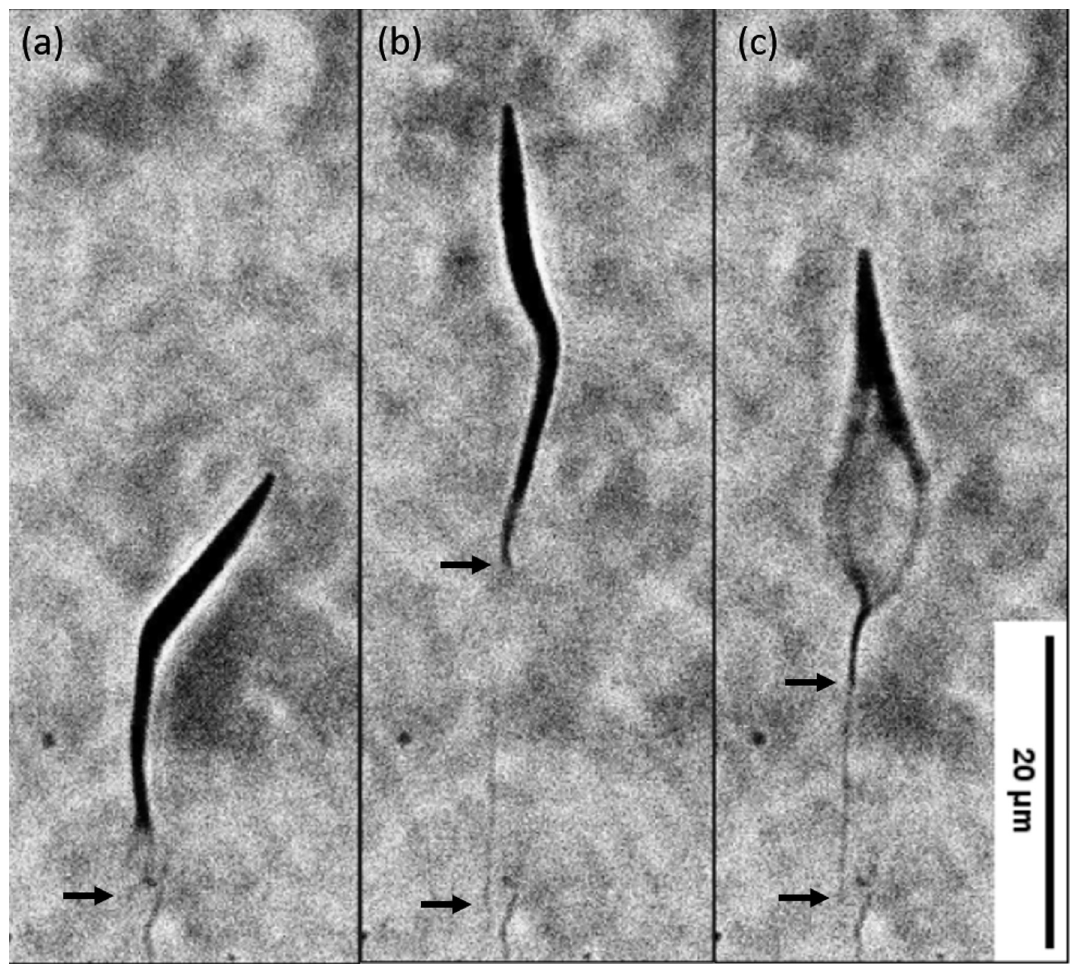
Fig 1. Filament formation. (a) Surface-bound epimastigote, at 0 shear stress. (b) The same epimastigote under a shear stress of 0.62 pN/ μ m 2 . A tether-like structure emerges from the flagellum, the arrows delimitate its length. (c) The flagellum resumes its beating motion while the tether is still attached to the surface. In this case the parasite did not return to its initial position.